Question: Name the type of graph shown.
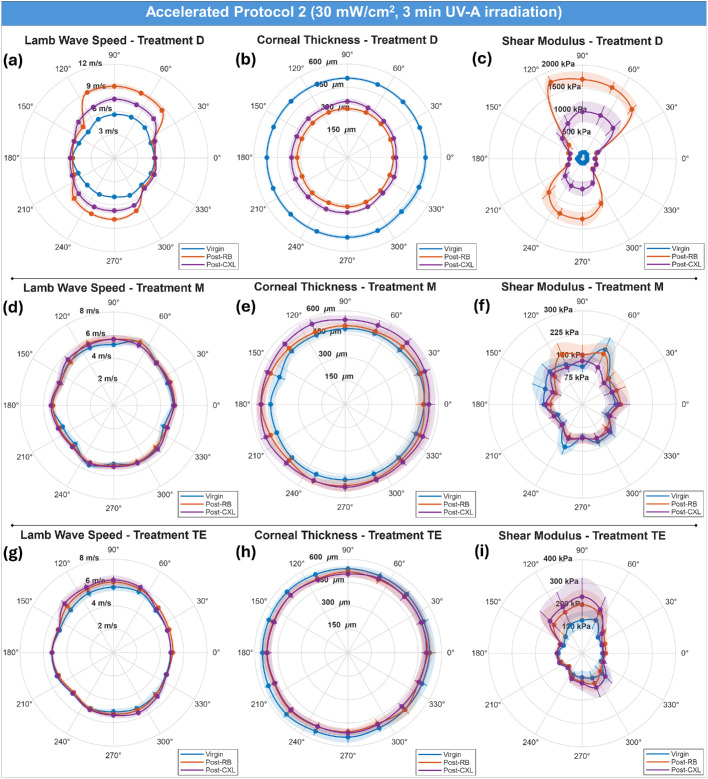
Answer: scatter